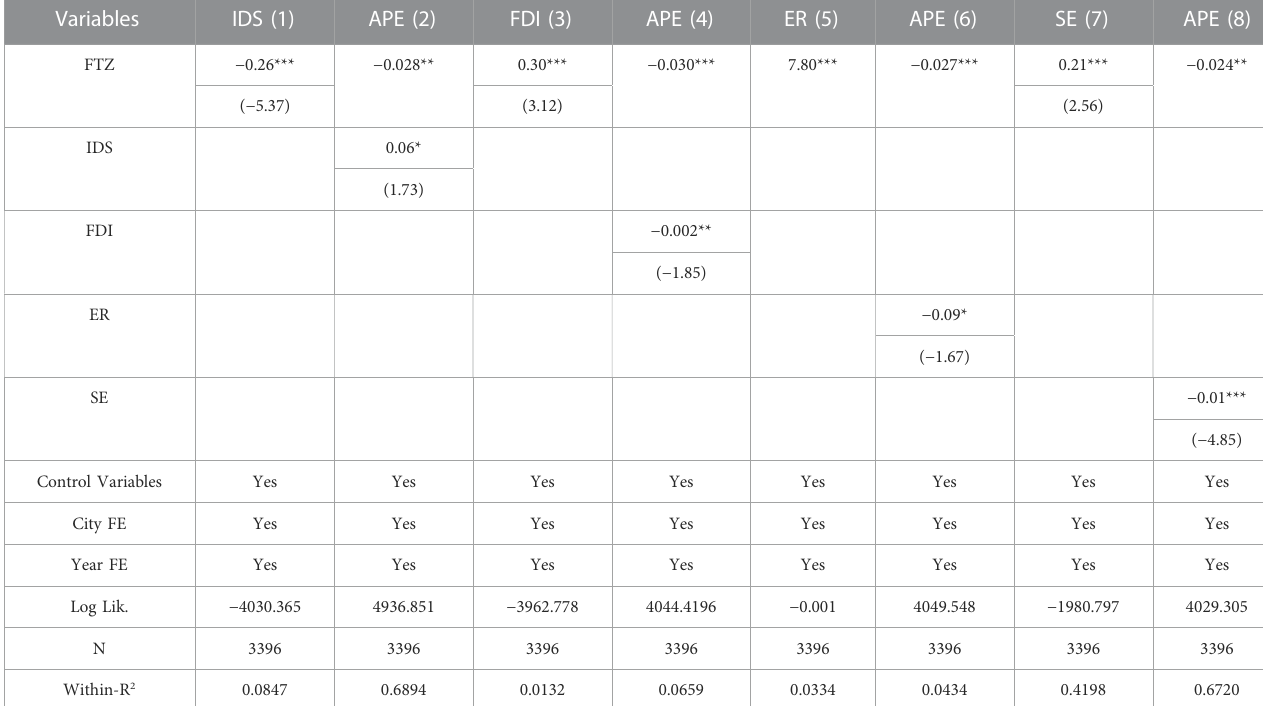
TABLE 10 Mechanism research results.